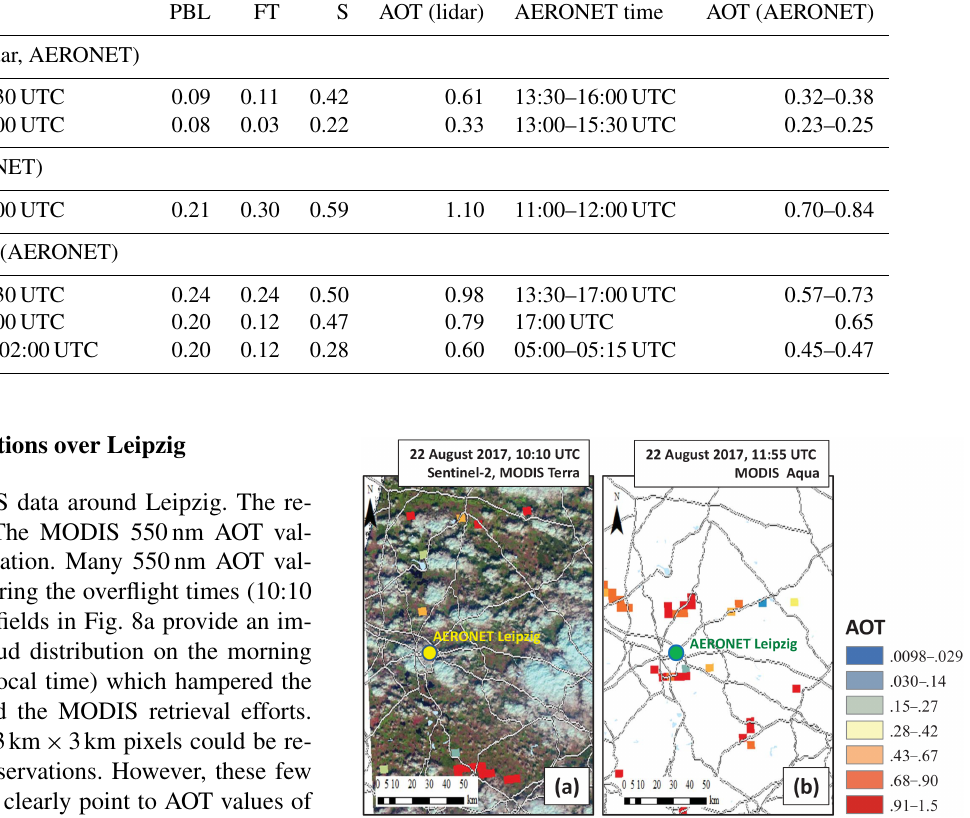
Figure 8. (a) Sentinel-2 cumulus cloud fields (bluish-white) and in- tegrated MODIS Terra color-scaled 550nm AOT values for 3km × 3km cloud-free areas (Leipzig, overpass at 10:10UTC), and (b) re- spective MODIS Aqua 550nm AOT retrievals (Leipzig, overpass at 11:55UTC). The yellow (a) and green (b) circles indicate the AERONET Leipzig site. Many red squares (AOT of 0.9–1.5) were retrieved from the MODIS observations north and south of the AERONET